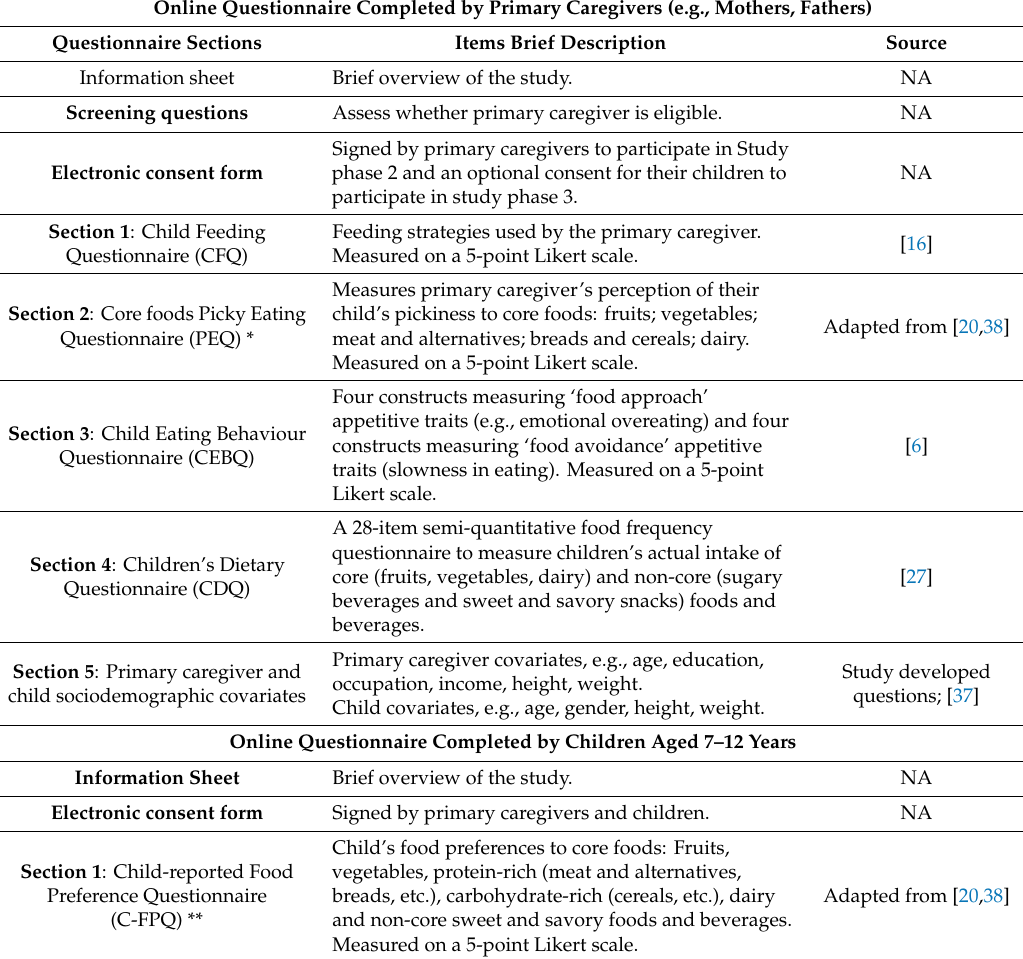
Table 1. Revised questionnaires completed by primary caregivers and children in Study phase